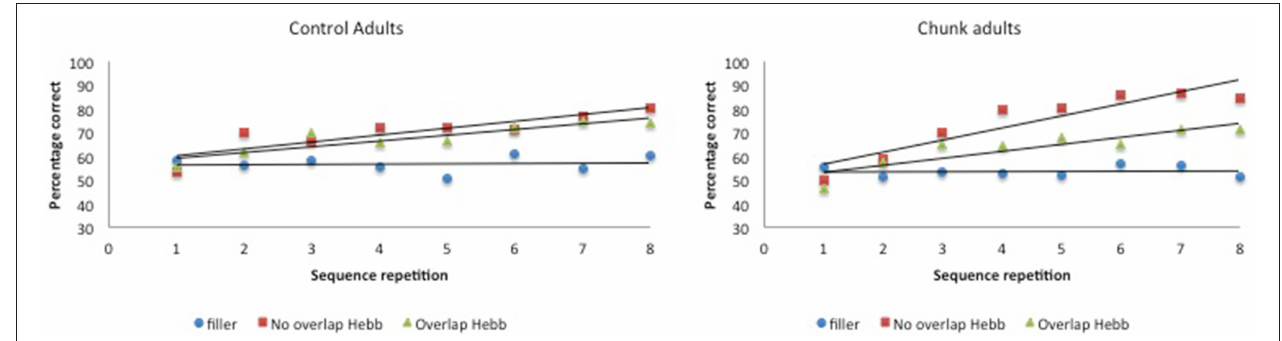
FIGURE 6 | Performance (percentage of correct scores) as a function of Sequence type (filler vs. Hebb non-overlap vs. Hebb overlap) and Sequence repetition (1–8) in the group with chunking and the control group, Experiment 3. Left panel: performance for control adults. Right panel : performance for chunk-encouraged